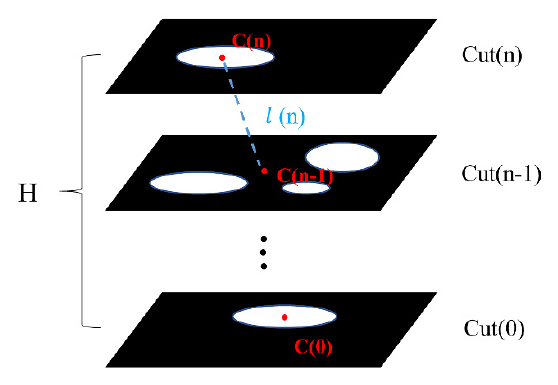
Figure 15. The centroid path tortuosity.